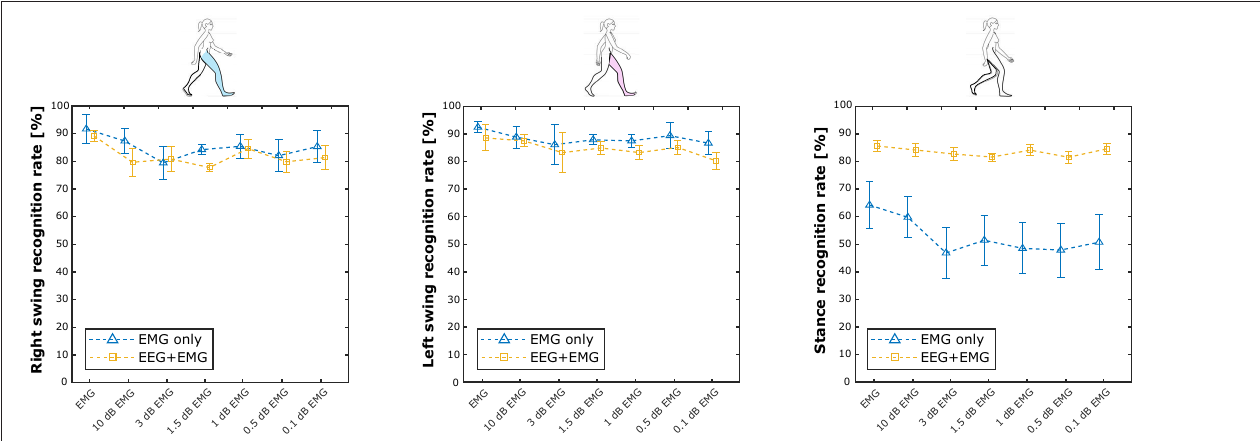
FIGURE 7 | Average results achieved by the hybrid approach (yellow lines), with respect to the EMG only approach (blue lines), is shown at different levels of signal-to-noise ratio (in dB) of the EMG signals, as right swing (left plot), left swing (mid plot), and stance (right plot) phases recognition